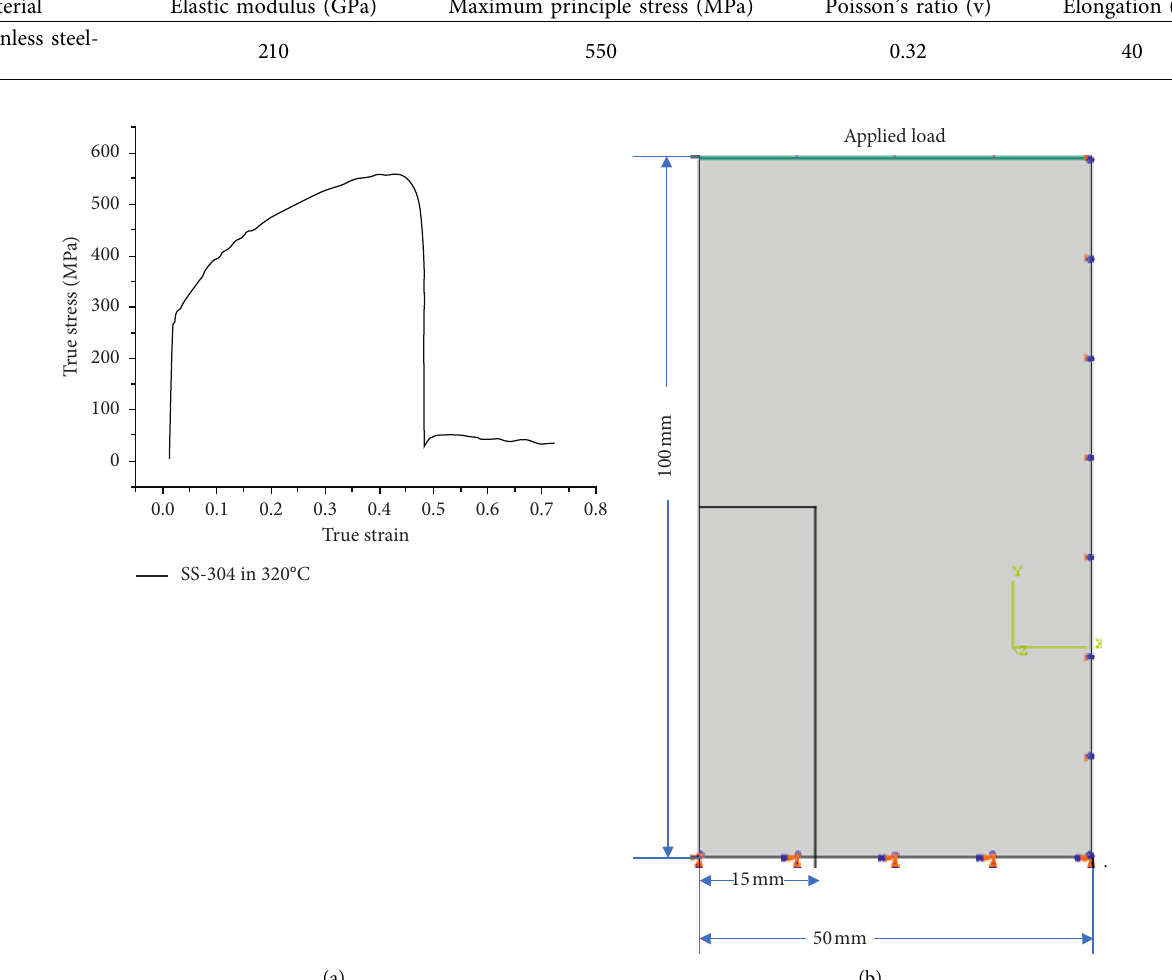
Figure 2: (a) The true tensile strain curve at high temperature. (b) 2D element used along with loading and boundary conditions.